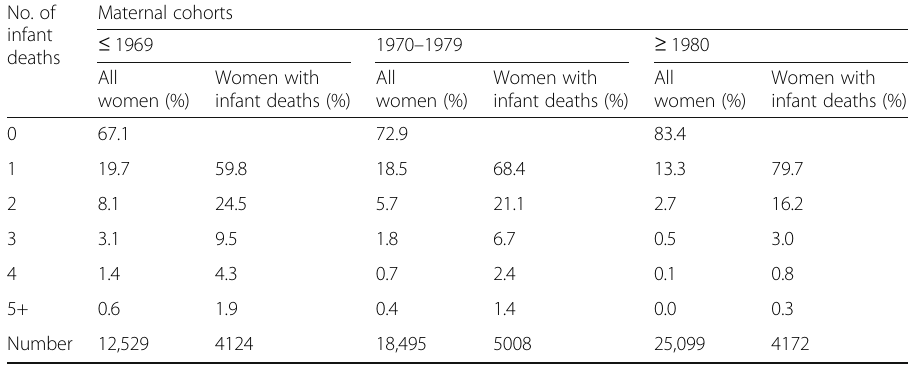
Table 2 Infant death clustering among three maternal cohorts in Nigeria, 1980 – 2013